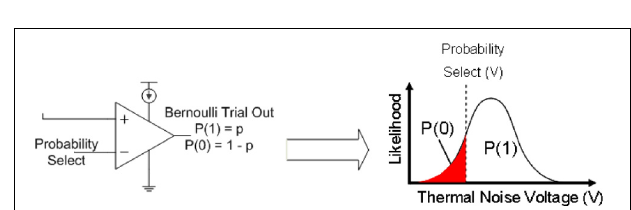
FIGURE 3 | Circuits for generating a Bernoulli random variable (1 with probability p and 0 with probability 1- p ). (A) Dynamic Bernoulli Probability Circuit. Thermal noise is trapped on the capacitor, amplified twice through two operational transconductance amplifiers (OTA) with gain of A i then put through a comparator with a probability select input. Note that these three OTA’s are the same basic circuit programmed to different functionality. (B) Nine-transistor OTA used in (A) for amplifier and comparator circuits.